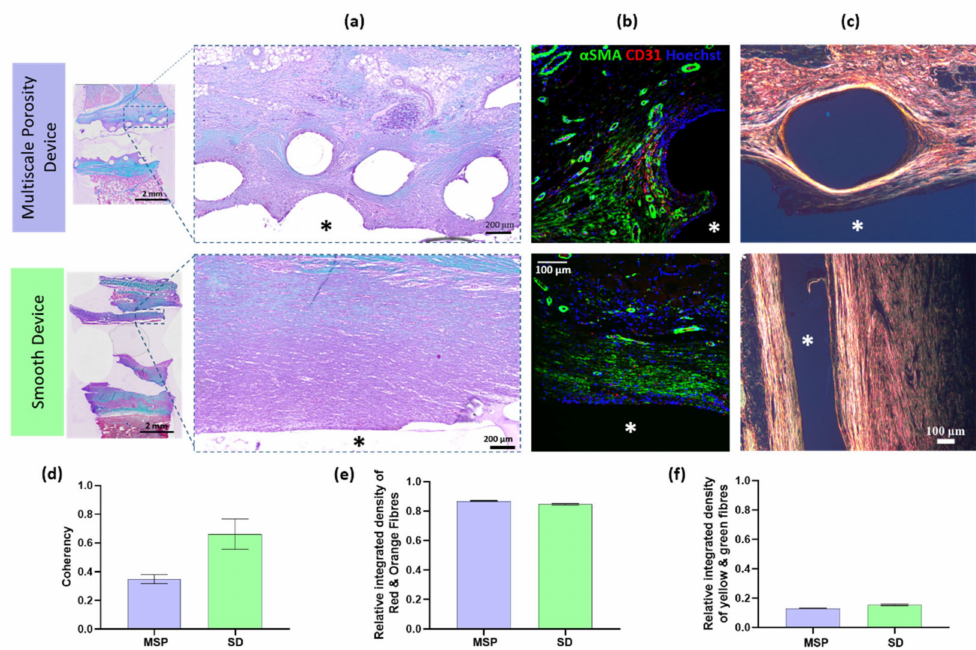
Figure 6. Histological analysis of fibrous capsule formation around multiscale porosity and smooth surfaced devices. ( a ) Masson’s trichrome images of core biopsy taken through device and adjacent surrounding tissue (Scale bar = 2 mm) with magnified representative image of the device space (*) and the fibrous capsule (Scale bar = 200 µ m). ( b ) Immunofluorescent images for analysis of myofibroblast density within the fibrous capsule (Hoechst, blue; α SMA, green; CD31, red). Scale bar = 100 µ m. ( c ) Polarized Light Microscopy (PLM) images of the fibrous capsules. Scale bar = 100 µ m. ( d ) Fibrous capsule coherency measurement using PLM. ( e ) Relative integrated density of red and orange collagen fibres (indicative of mature/permanent collagen deposition). ( f ) Relative integrated density of yellow and green fibres (indicative of immature/active collagen deposition). n = 2 per group; data are represented as means ± standard deviation. No significant difference was determined